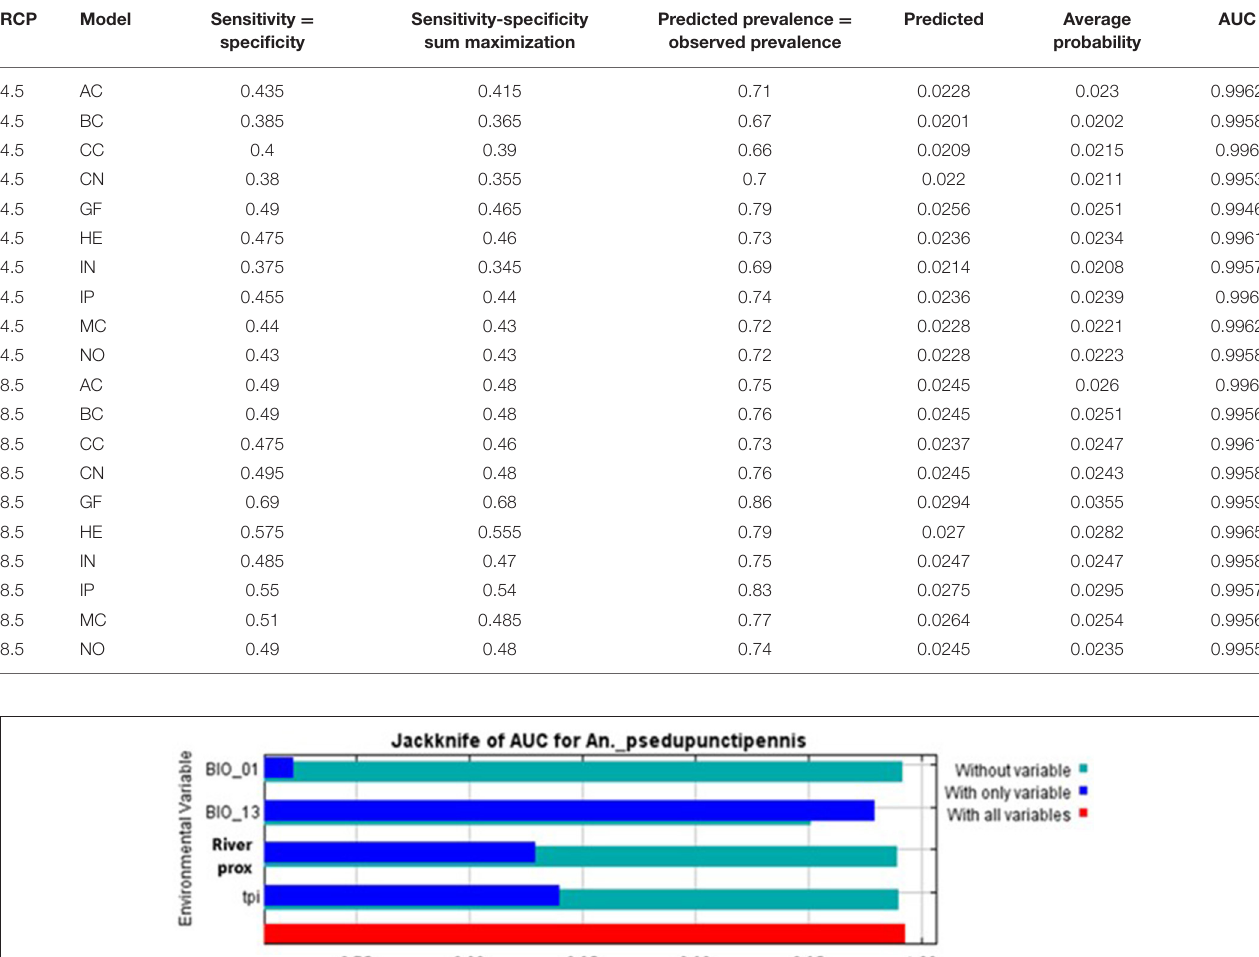
TABLE 1 | Evaluation results to select the best model to project.